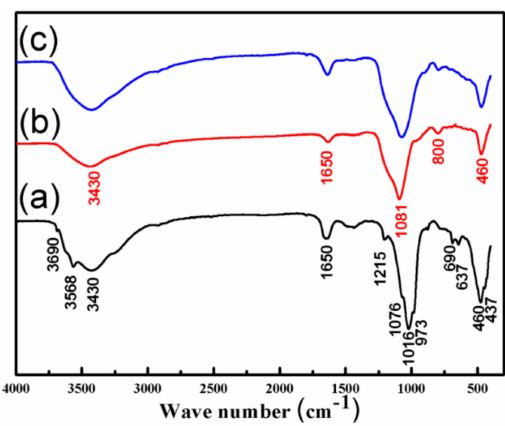
Figure 3. FTIR spectra of raw sepiolite ( a ), amorphous SiO 2 nanotubes ( b ), and Mg(OH) 2 –SiO 2 composite ( c